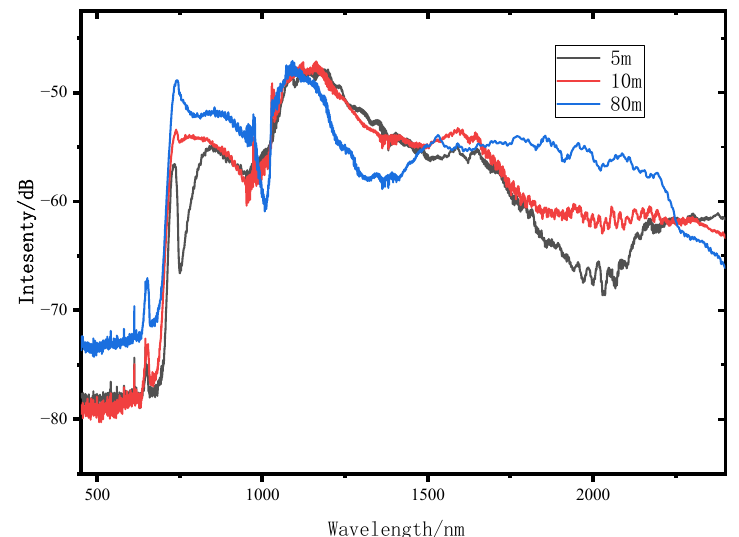
Figure 6. Spectral evolution after different GRIN fiber length at 30 W input power.